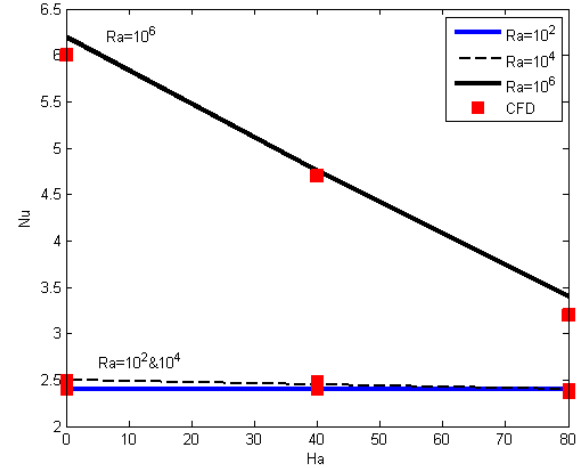
Figure 6. Examining the Nusselt number relative to the Hartmann number at ϕ = 0.05, AR = 0.5, and α = 0.